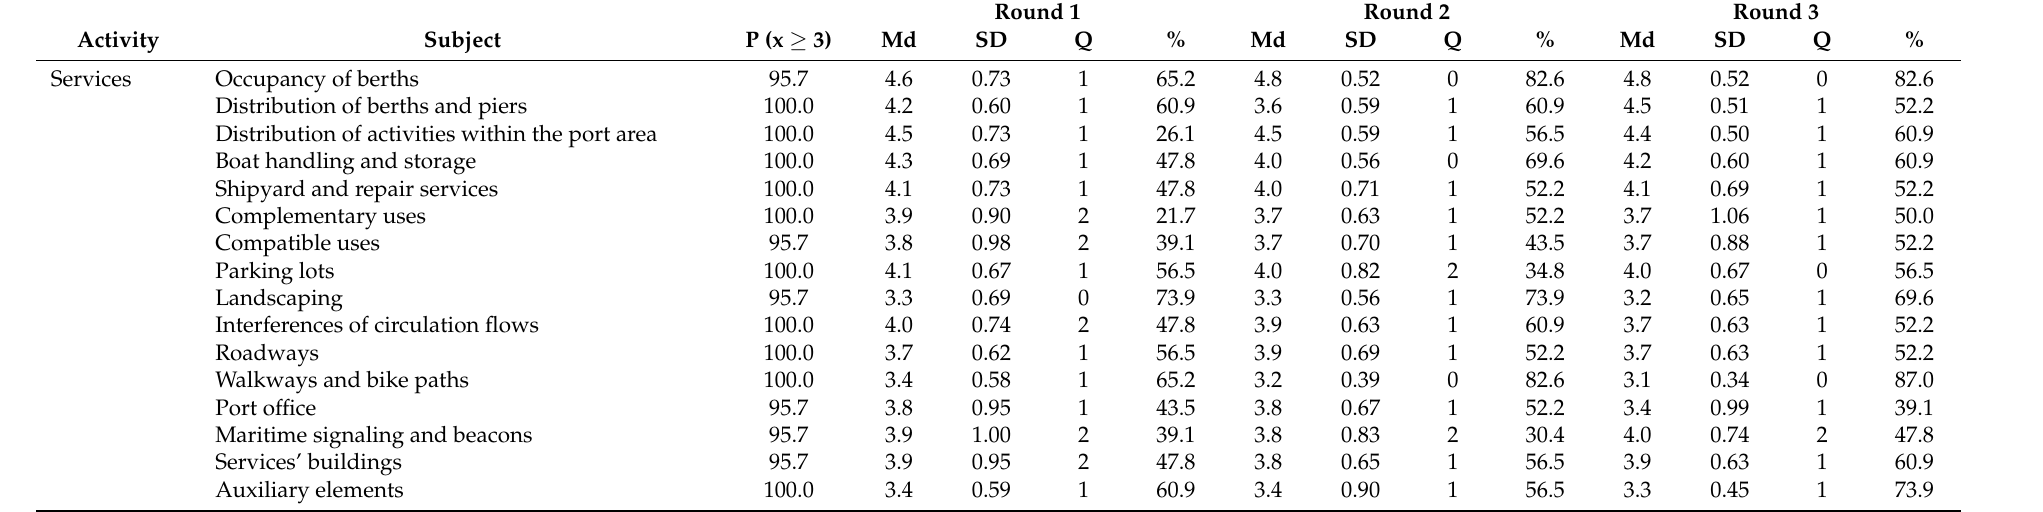
Table A2. Statistical results from rounds related to the landscape of marinas (Delphi